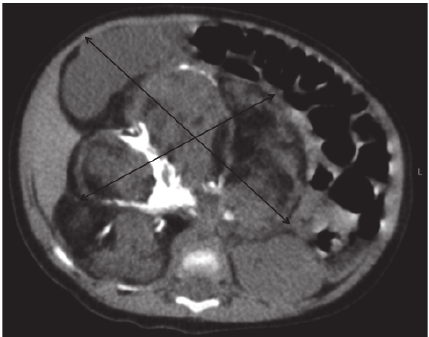
Figure 1: MRI of abdomen showing heterogeneous mass extending from the right suprarenal fossa and into the peritoneal cavity, measuring 10.2 cm × 10.5 cm × 8.5 cm (AP × TRV × SI). There are multiple large collections of high T2 signal consistent with cystic component degeneration.